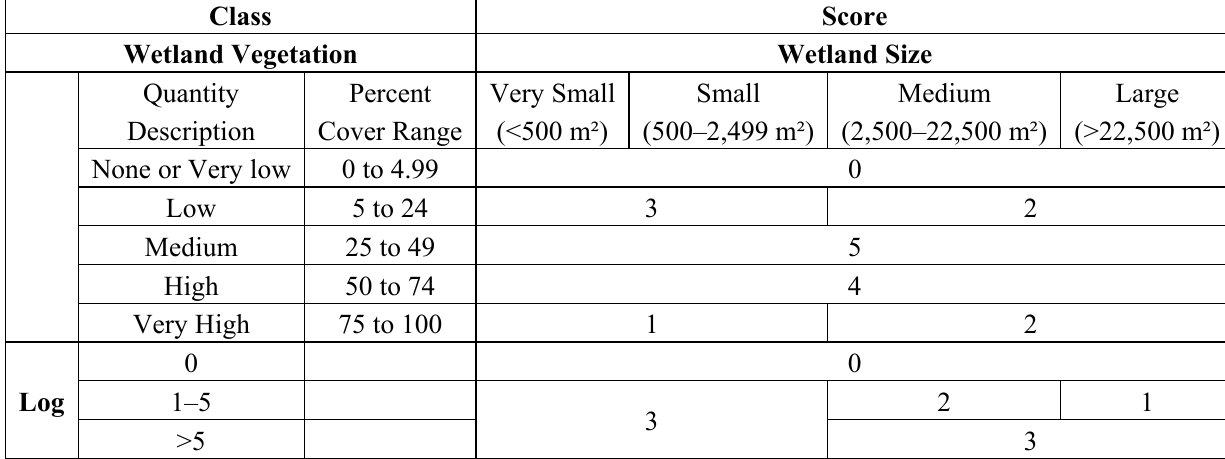
Table 1. Scoring system used as an illustrative example of potential Blanding’s